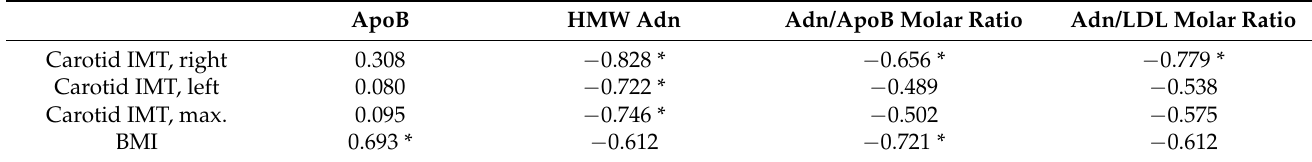
Table 2. Significant Spearman correlation coefficients between carotid IMT and laboratory data in male